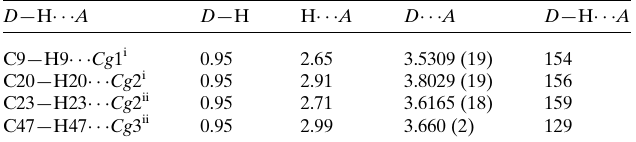
Table 2 Experimental details. Crystal data Chemical